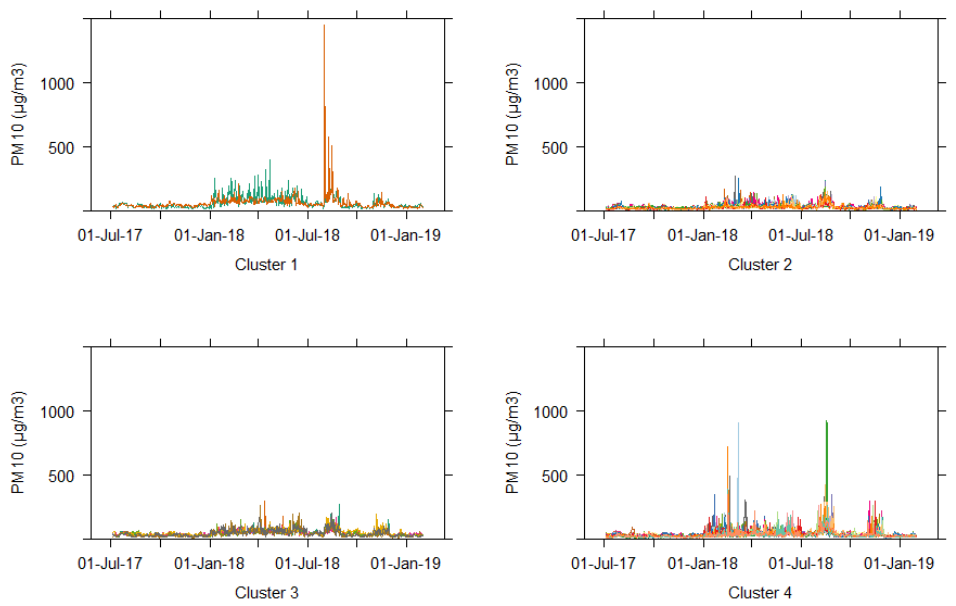
Figure 13. Time series plots for each cluster formed based on DTW and k-Means for daily maximum PM 10 time series data.